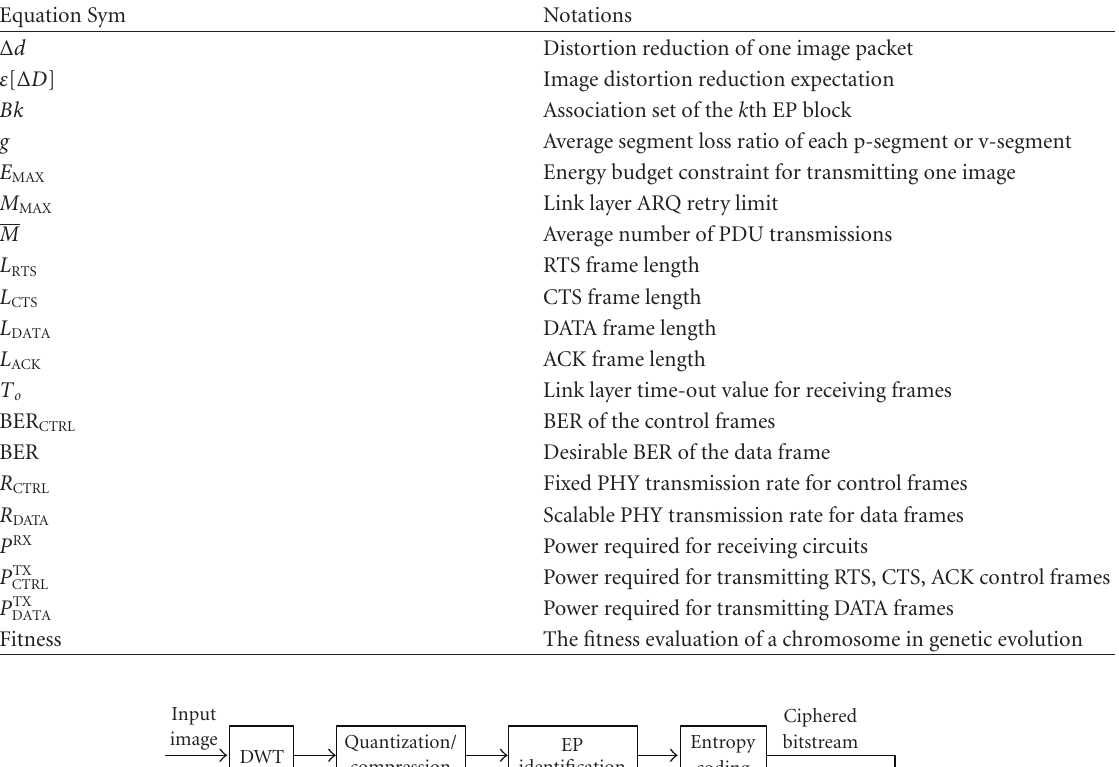
Table 1: Major symbol summarization for equations.